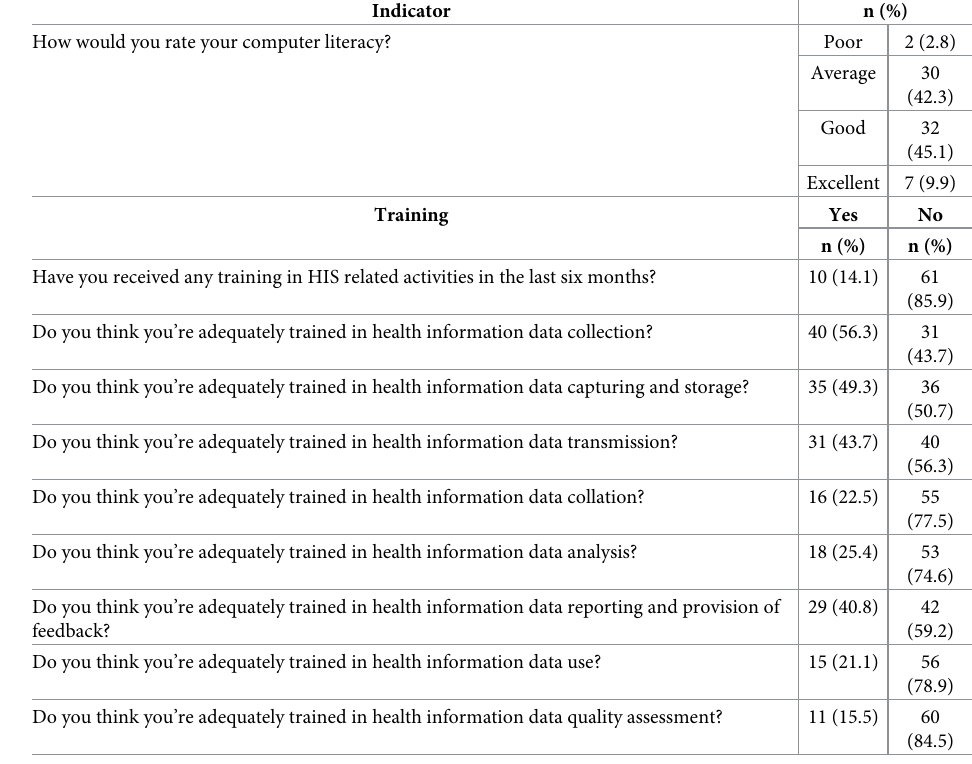
Table 3. Training on management of health information system.